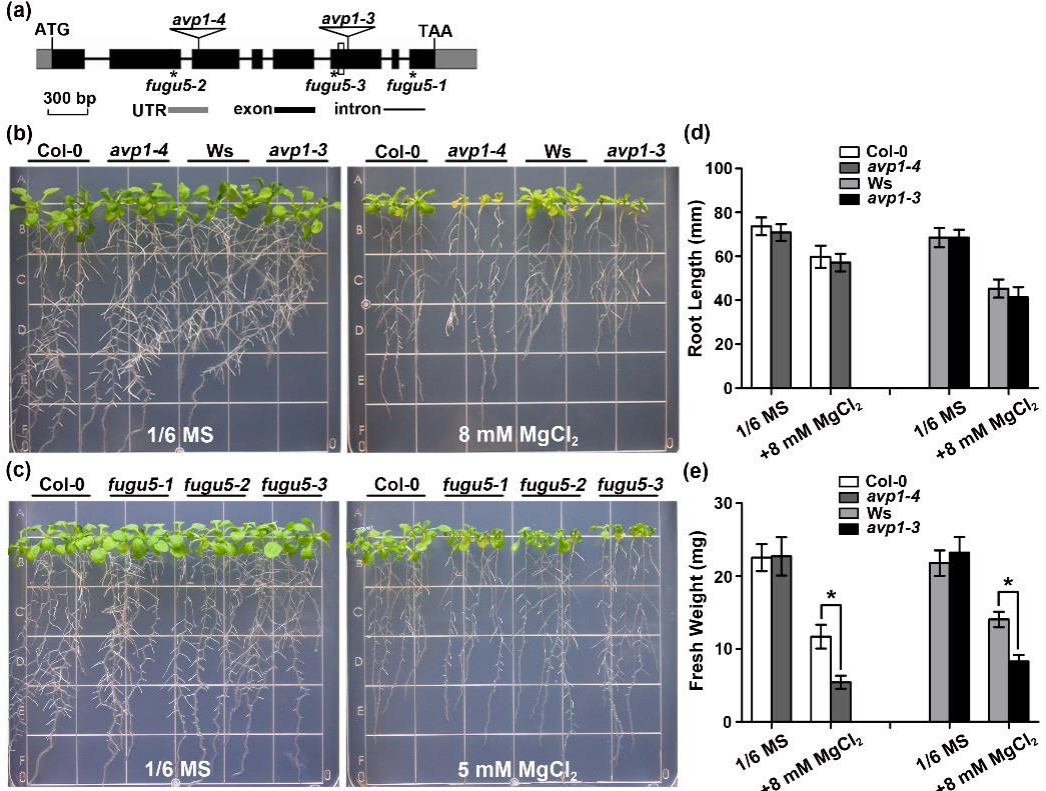
Figure 1. The avp1 mutant plants are hypersensitive to high-Mg conditions. ( a ) Schematic diagram of the AVP1 gene. Coding regions are depicted as black boxes, and the 5’ or 3’ UTRs are shown as shaded boxes and lines represent introns to scale. The molecular lesion in each of the five loss-of-function avp1 alleles is indicated by open triangles or asterisks. ( b ) Growth phenotype of wild types Col-0 and Ws and corresponding mutant plants avp1-4 and avp1-3 under different ionic stress conditions. Five-day-old seedlings were transferred onto 1/6 MS medium or 1/6 MS medium supplemented with 8 mM MgCl 2 . Photographs were taken on the 10th day after transfer. ( c ) Growth phenotype of Col-0 and three fugu5 mutant alleles on 1/6 MS medium or 1/6 MS medium supplemented with 5 mM MgCl 2 . ( d ) Root length and ( e ) fresh weight of seedlings on the 10th day after transfer. Data are presented as the mean ± SD of four replicate experiments. Asterisks indicate statistically significant differences compared with the Col-0 or Ws (Student’s t -test, * p <